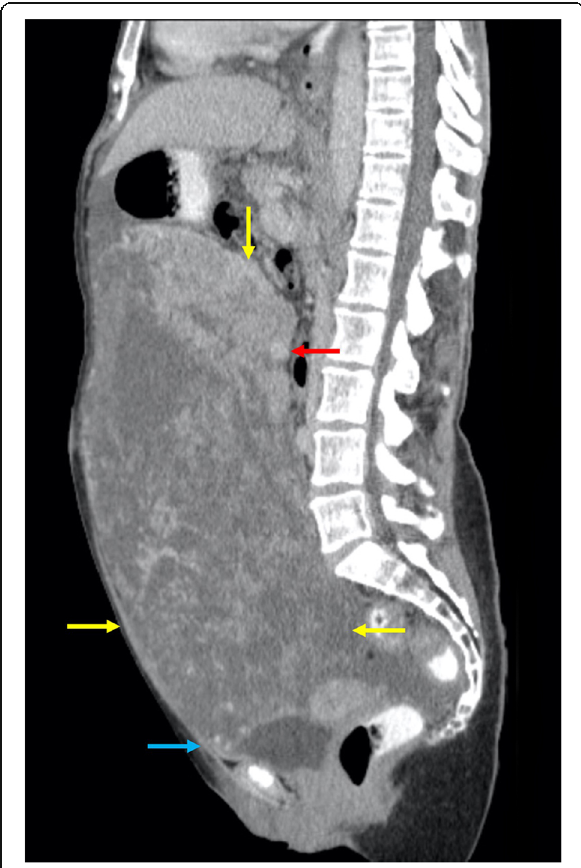
Fig. 6 Sagittal post-contrast MDCT image of the entire intraperitoneal tumour (yellow arrows) at midline. The previous enlarged vessels are also seen behind the tumour (red arrow), as well as the vessels of the anterior reflection of the pelvic peritoneum (light blue arrow)